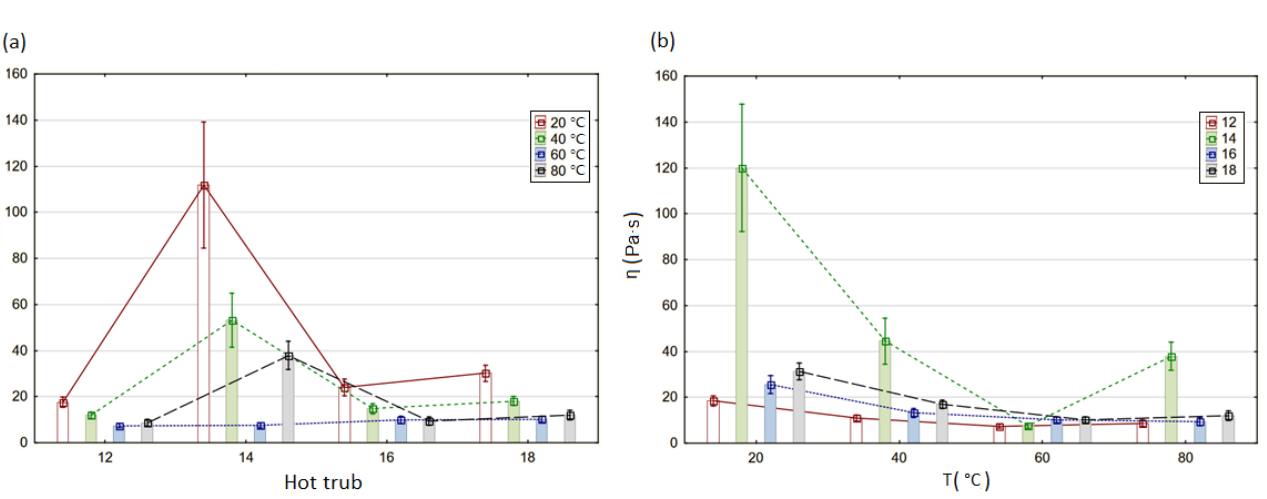
Figure 3. Graphs of mean viscosity values of hot trubs grouped by ( a ) recipe and ( b ) temperature ( n = 3, α = 0 .05).